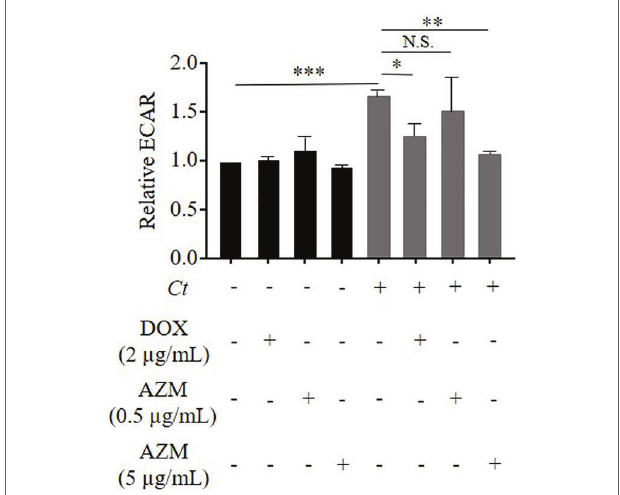
FIGURE 2 | Impact of DOX and AZM on glycolytic activity in C. trachomatis infected HeLa cells. Cells were treated with 2 μ g/ml of DOX, 0.5 or 5 μ g/ml of AZM for 24 h. Glycolysis was measured by Glycolysis stress test kit. ECAR, extracellular acidification rate; Ct , C. trachomatis ; DOX, doxycycline; AZM, azithromycin ( n = 3–9; Mean ± SEM, Sidak’s multiple comparison: * p ≤ 0.05; ** p ≤ 0.01; *** p ≤ 0.001; and N.S. not significant).